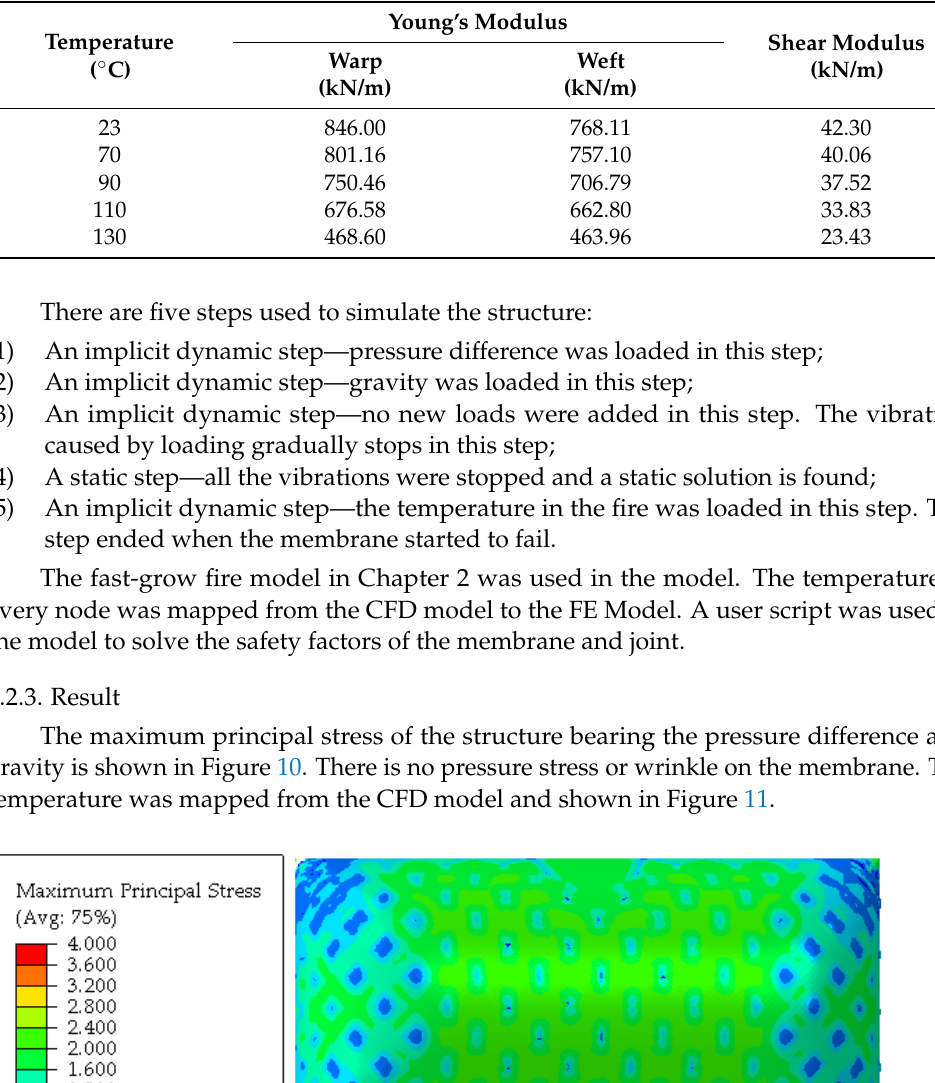
Figure 11. Temperature on the membrane structures. The stress perpendicular to the welded joint is shown in Figure 12. There is only a small variation in stress before and during the fire. The maximum displacement changed from 92.70 mm to 97.77 mm.